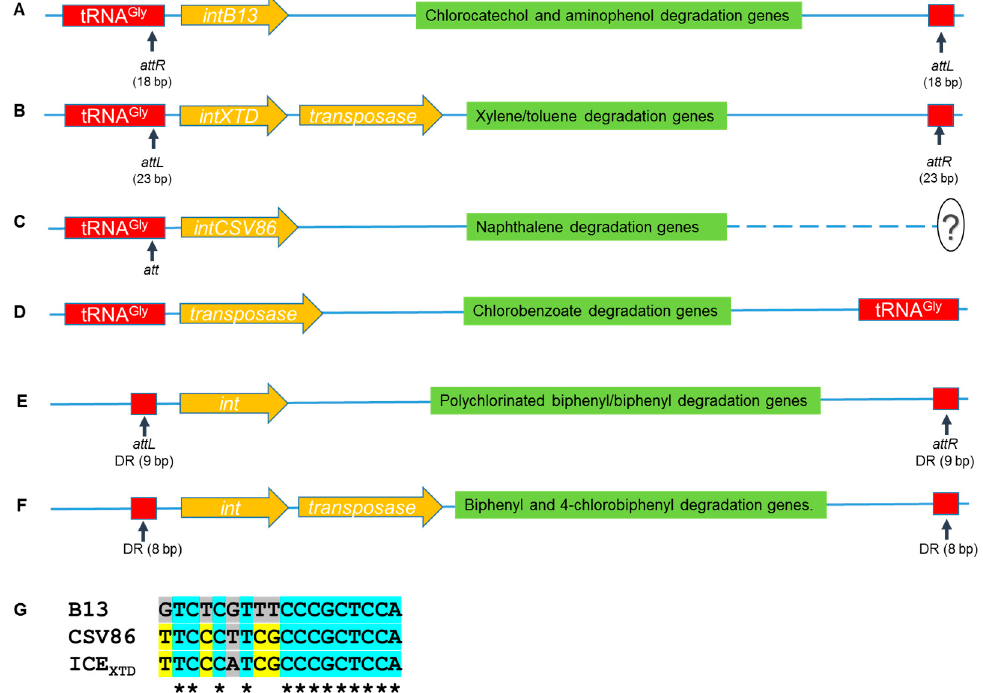
Figure 1. The structural features of various integrative conjugative elements (ICEs) involved in aromatic compound metabolism from: ( A ) clc element of Pseudomonas sp. B13; ( B ) ICE XTD of Azoarcus sp. CIB; ( C ) ICE CSV86 element of Pseudomonas putida CSV86; ( D ) clc element of Pseudomonas aeruginosa JB2; ( E ) ICE KKS102 4677 from Acidovorax sp. strain KKS102; and ( F ) Tn 4371 transposon most likely to be an ICE from Cupriavidus oxalaticus . Panel ( G ) represents multiple sequence alignment of attachment site (‘ att ’) region of the 3’ end of tRNA Gly of Pseudomonas sp.B13, as B13, Pseudomonas putida CSV86 as CSV86 and Azoarcus sp. CIB as ICE XTD . Question mark in panel C depicts the incomplete / unidentified downstream region and attR site. Figure is not to the scale. tRNA: